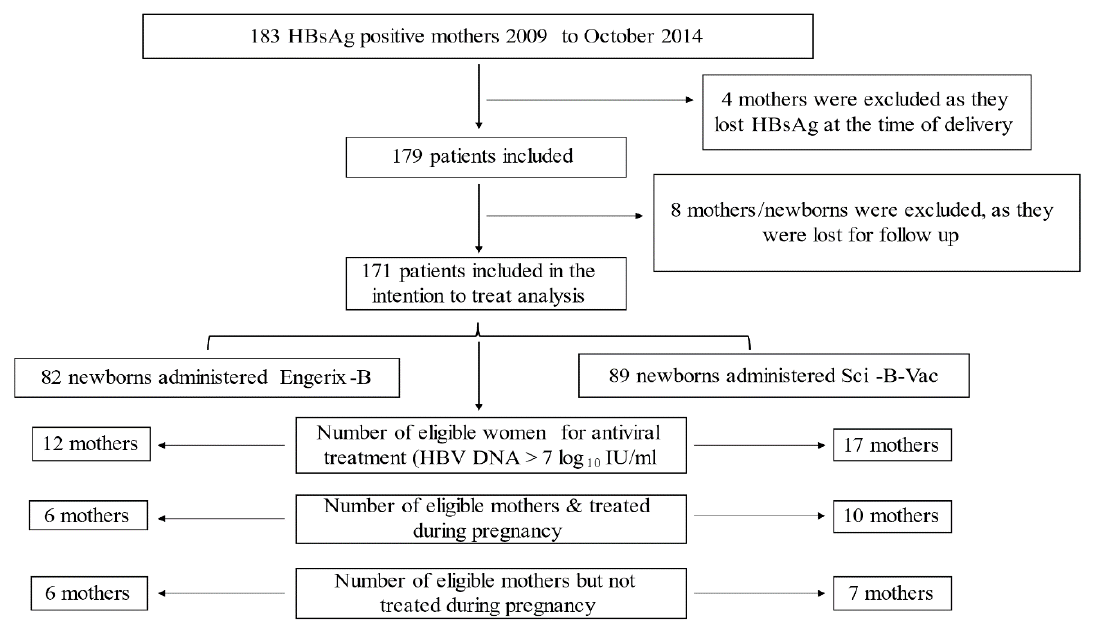
Figure 1. The intention to treat analysis study flowchart.